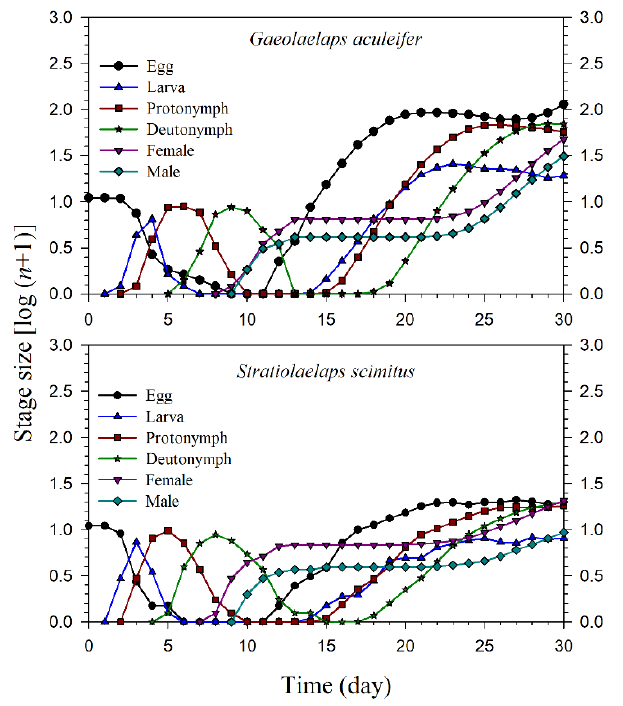
Figure 6. Population growth and stage structure of G. aculeifer and S. scimitus fed on T. putrescentiae .